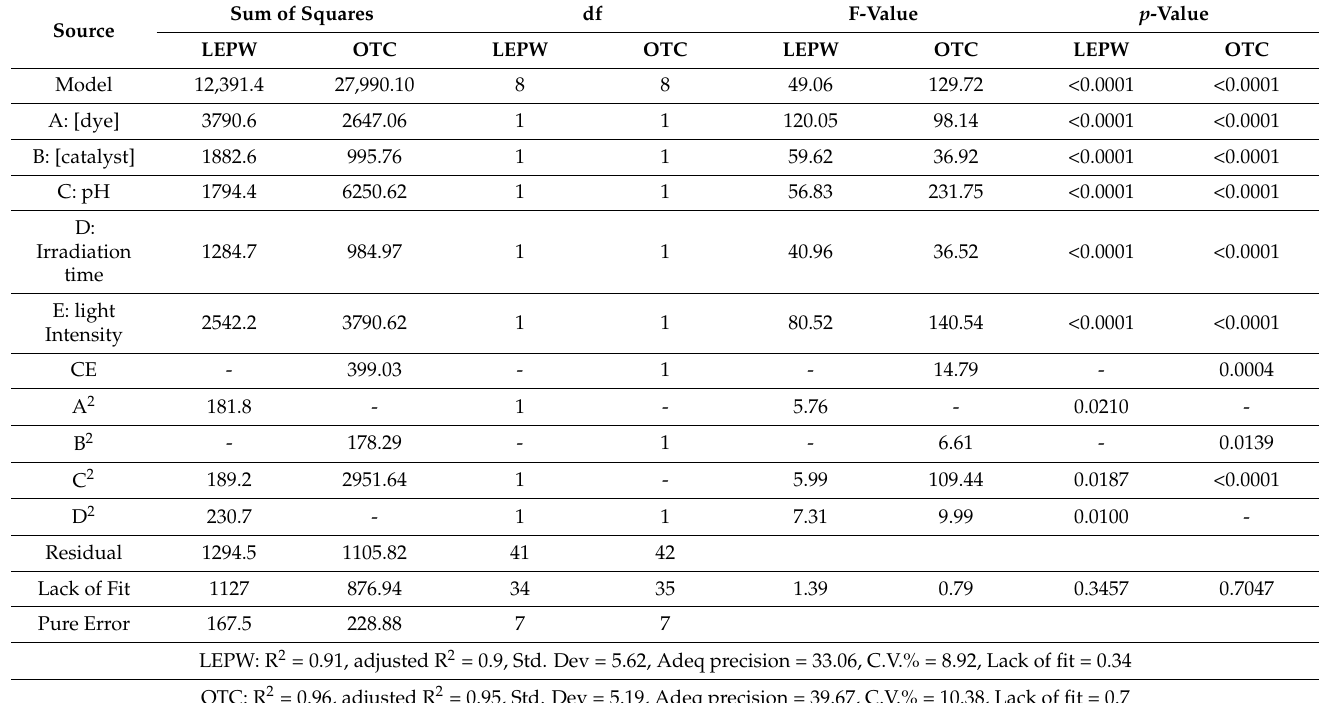
Table 4. ANOVA results for models of COD and OTC photocatalytic